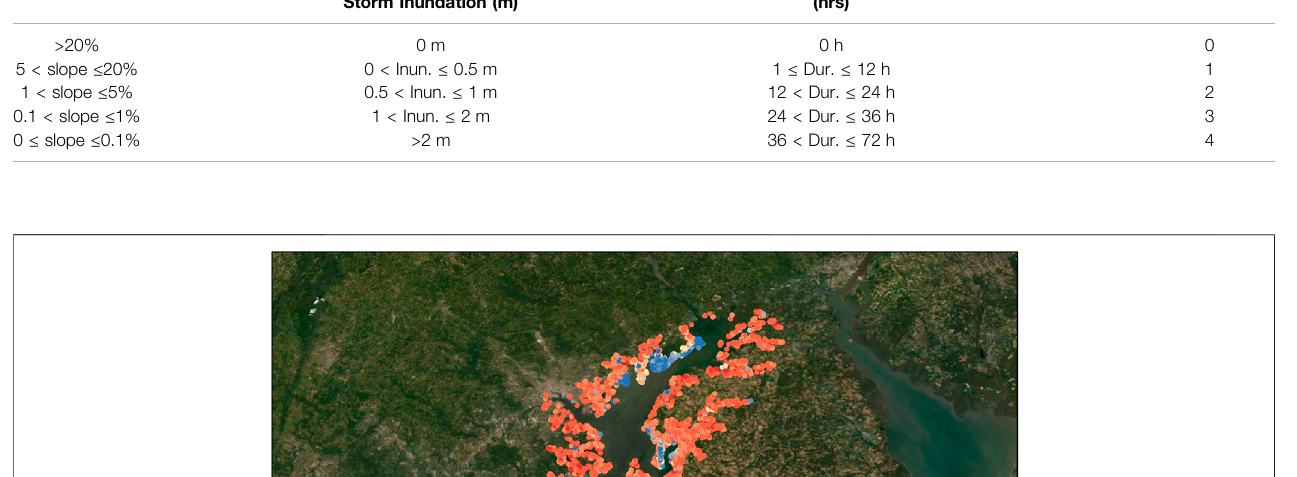
Frontiers in Environmental Science |